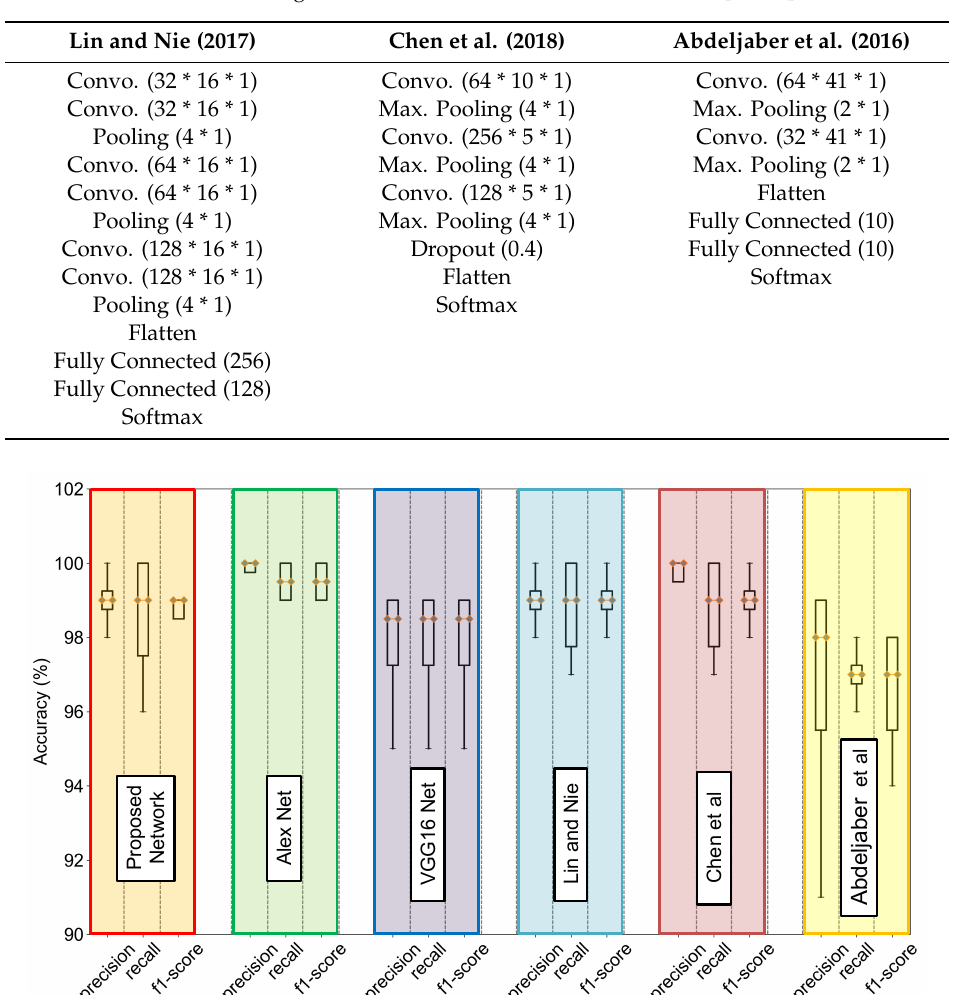
Table 5. Configuration of di ff erent 1D CNN architectures [33–35].